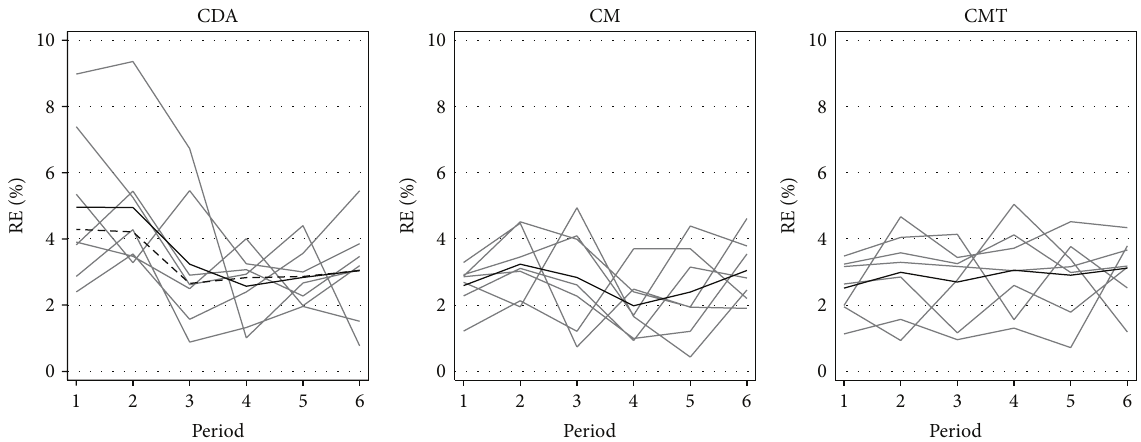
Figure 3: Average RE CDA in the CDA phase, by treatment. This figure displays the development of the average relative error in each session’s CDA phase (RE CDA ), in each of the three treatments (thin grey lines), the mean over all sessions (solid black line), and the mean over all sessions without the first session in the case of the stand-alone CDA (dashed black line, leftmost panel).